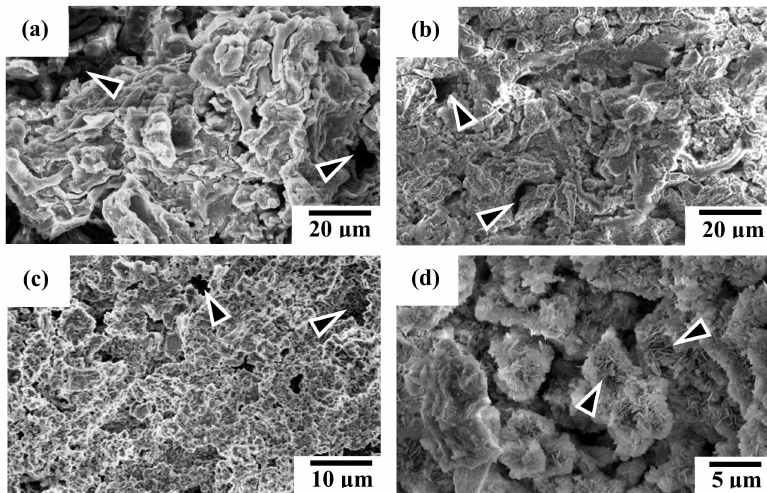
Figure 8. SEM corroded surface morphologies of the ( a ) AZ91D Mg alloy, ( b ) AZ91D-AP, ( c ) HAC, and ( d ) Sr-HAC coatings after potentiodynamic polarization